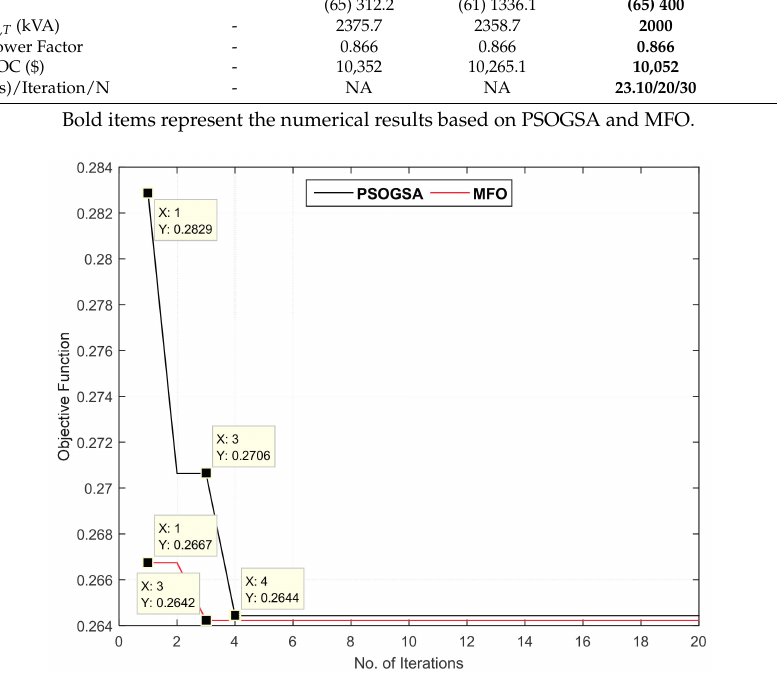
Figure 20. The change of objective function (LVCI) with iterations number for 69-bus at unity PF.